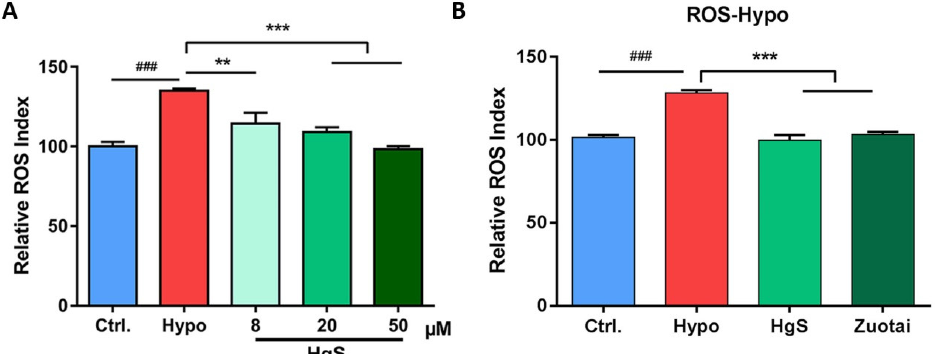
Figure 2. The effects of HgS and Zuotai to abnormal ROS level of RIN-14B cells. ( A ) Different doses of HgS inhibited the ROS induced by hypoxia modeling (5% O 2 , 48 h), ( B ) the effects of HgS and Zuotai on ROS inhibition. ### P < 0.001 represent compared with control. ** P < 0.01, *** P < 0.001 represent compared with model (hypoxia). P < 0.05 was considered as statistically significant calculated by ANOVA.